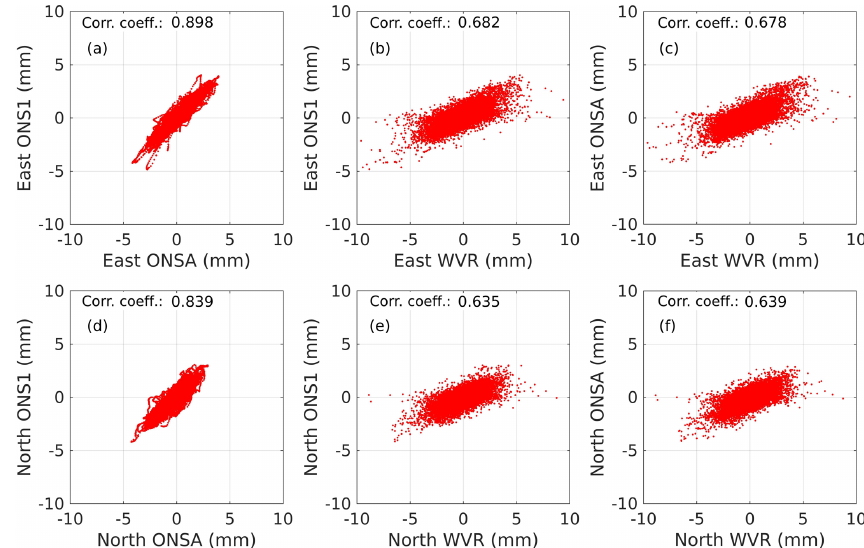
Figure 12. Correlations between estimated wet gradients from the WVR, ONSA, and ONS1 using all data from the period 2013–2016. The data in the graphs with ONSA and ONS1 (a, d) have the original 5min resolution, whereas the GPS data are averaged over 15min when compared to the WVR data ( b , e and c , f ). The correlation coefficients obtained when the east gradients from the WVR were correlated with the original total gradients from GPS were 0.633 for ONSA and 0.637 for ONS1. The corresponding values for the north gradients were 0.575 for WVR-ONSA and 0.571 for WVR-ONS1. This supports our assumption that the ECMWF hydrostatic gradients are reasonably accurate when carrying out a linear interpolation between the 6h samples.